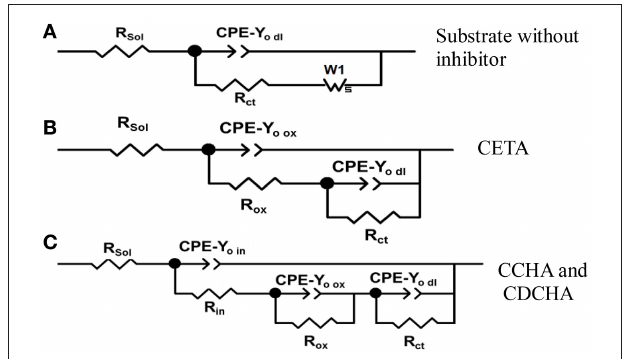
FIGURE 10 | Equivalent electrical circuits used to adjust the experimental impedance data. (A) Substrate (Zinc) without inhibitors; (B) CETA (ethanol-ammonium caprylate); (C) CCHA (cyclohexyl-ammonium caprylate) and CDCHA (dicyclohexylammonium